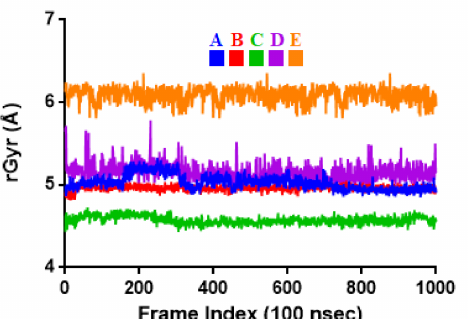
Figure 4. Stability and flexibility of the selected flavonoid derivatives complexed with M pro over the course of 100 ns. ( A ) is the RMS deviation and ( B ) is the RMS functions of the C α of each complexes. Color codes denote: Quercetin-3-O-Neohesperidoside (A), Quercetin 3-Rhamnoside (B), Myricitrin (C), Rutin (D), and Myricetin 3-Rutinoside (E).